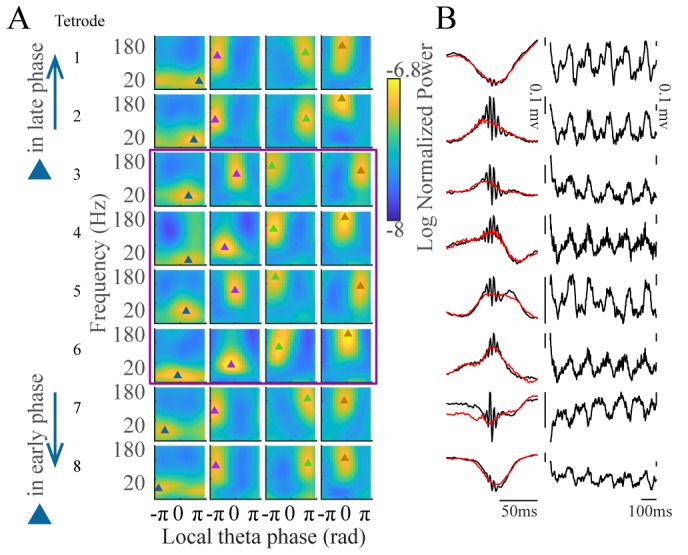
Clustering of tetrode data.(A) Average FPP for each cluster (columns) for eight example tetrodes in CA1 during awake periods. Tetrodes are ordered by the gravity phase of S-gamma (late in the theta cycle, top, to early in the theta cycle, bottom). The purple rectangle indicates tetrodes with S-gamma at the peak of theta, similar to what was found using probe recordings from the channel with the largest ripple power. (B) Left: average LFP traces aligned to either the negative ripple peak (black) or ripple power (red, root mean square) during sleep, for each tetrode show in A. Right: Example LFP traces during theta periods for each tetrode shown in A.